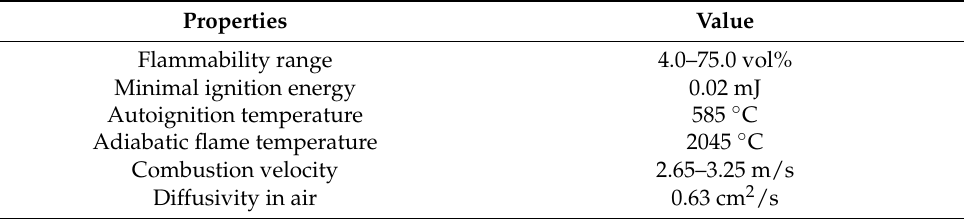
Table 1. Physicochemical properties of hydrogen during combustion with ambient